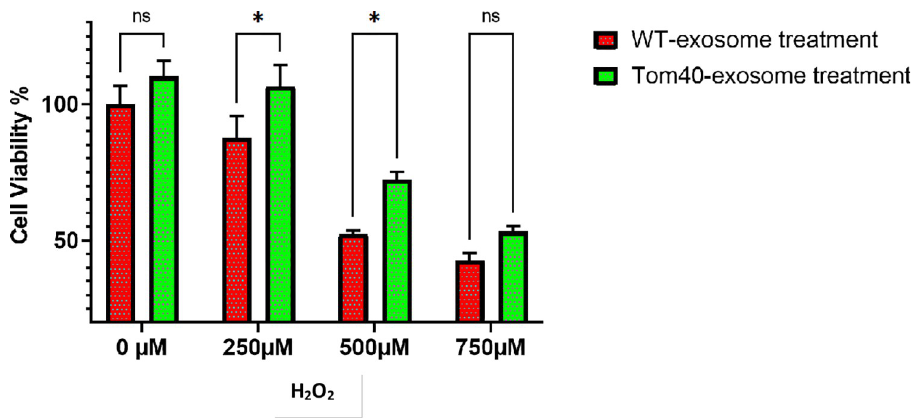
Fig 4. Tom40-exosome protects HEK293 cells against H 2 O 2 induced oxidative stress. Cells were incubated with exosomes for 16 hours and then treated with H 2 O 2 for 4 hours. MTT assay was performed to detect metabolically viable cells. The data are means ± SEM of 4 replicates. The data were analyzed by Two-way ANOVA and the significance level was corrected for multiple testing by false-discovery rate ( � P <